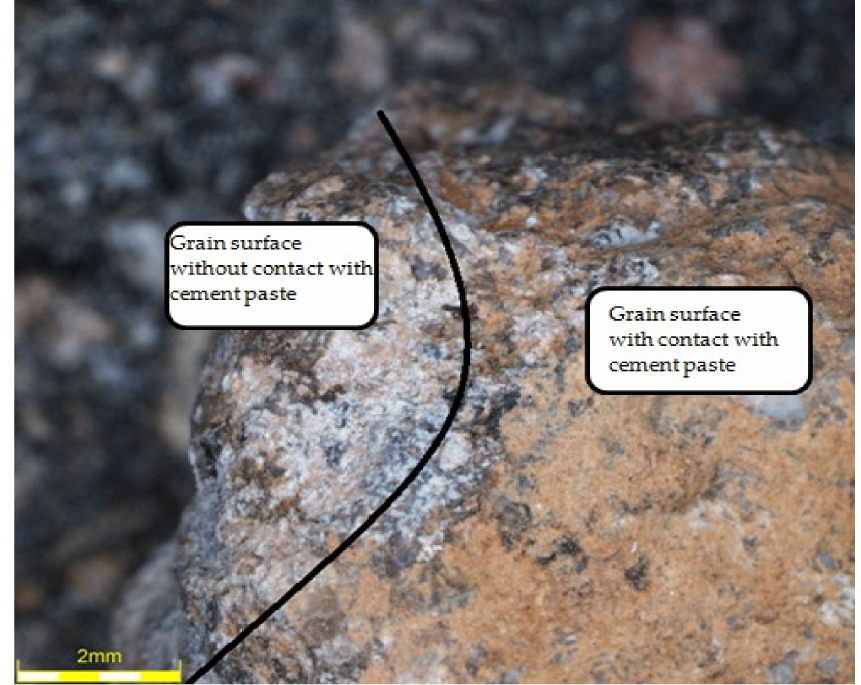
Figure 18. The granite after thermo-mechanical